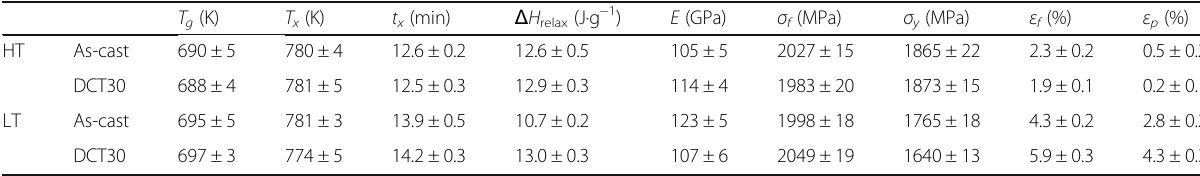
Table 1 A summary of thermal and mechanical data for the sample in this work